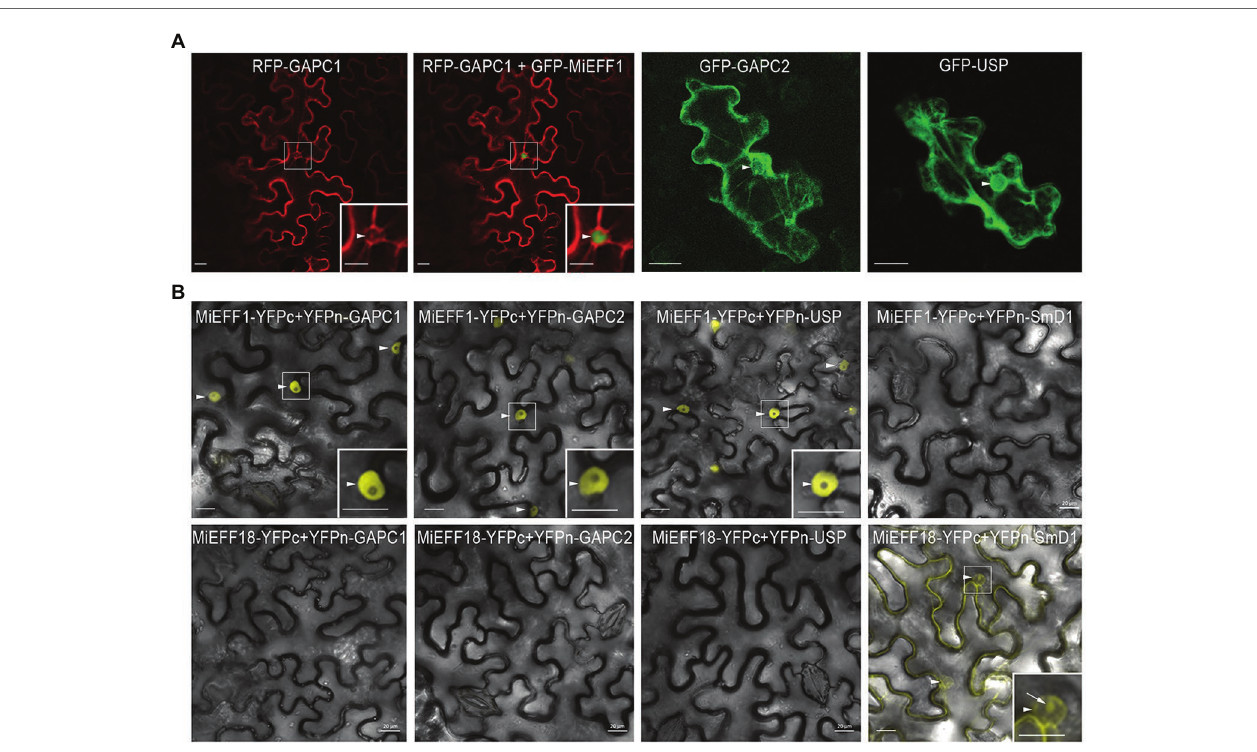
FIGURE 2 | MiEFF1 interacts with AtUSP, AtGAPC1, and AtGAPC2 in planta . (A) Localization of GFP-AtUSP, -AtGAPC1, and -AtGAPC2 in Nicotiana benthamiana epidermal leaf cells. Enlargements of the area framed are shown. Arrowheads indicate nuclei. (B) MiEFF1 interacts with AtUSP, AtGAPC1, and AtGAPC2 in the nucleus in Nicotiana benthamiana cells. Confocal images of YFP fluorescence in bimolecular fluorescence complementation (BiFC) experiments with MiEFF1-YFPc and YFPn-GAPCs/USP fusion proteins expressed in Nicotiana benthamiana epidermal cells. MiEFF18 and AtSmD1b were used as controls. Three independent experiments were performed with similar results. Enlargements of the area framed are shown. Arrowheads indicate nuclei, arrow indicates nucleolus. Bars = 20 μ